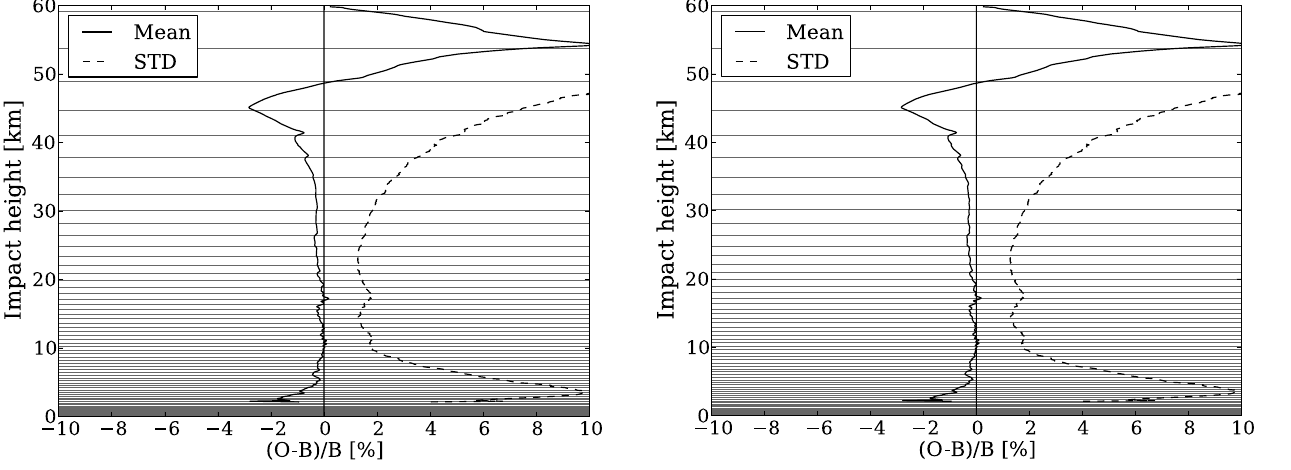
Figure 8. Bending angle innovation statistics, using hydrostatic re- fractivity (Eq. 10, including the moisture term) evaluated on one additional pseudo-level per model layer, and using an exponential function of refractivity with height to evaluate the Abel integral be- tween the model/pseudo-levels.